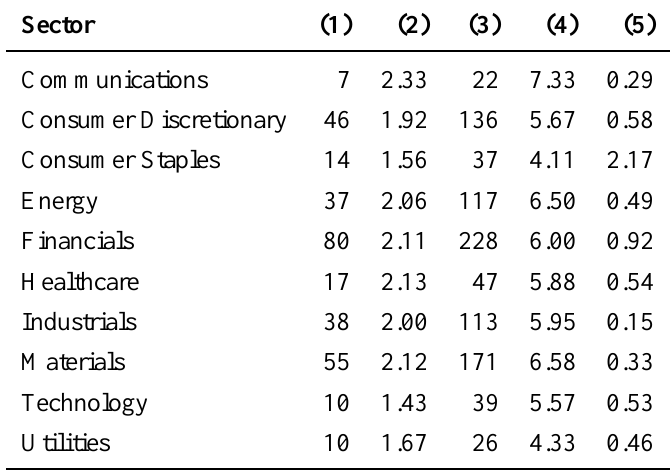
Table 2. The sum of node degrees for stocks belonging to the studied economic sectors in MST (1) and PMFG (3) based on partial mutual information, the average node degree for stocks belonging to the studied sectors in MST (2) and PMFG (4) based on partial mutual information and the average earnings per share (EPS) ratio for stocks belonging to the studied sectors (5). There is a negative correlation between the EPS ratio in a sector and the sector’s average importance in the